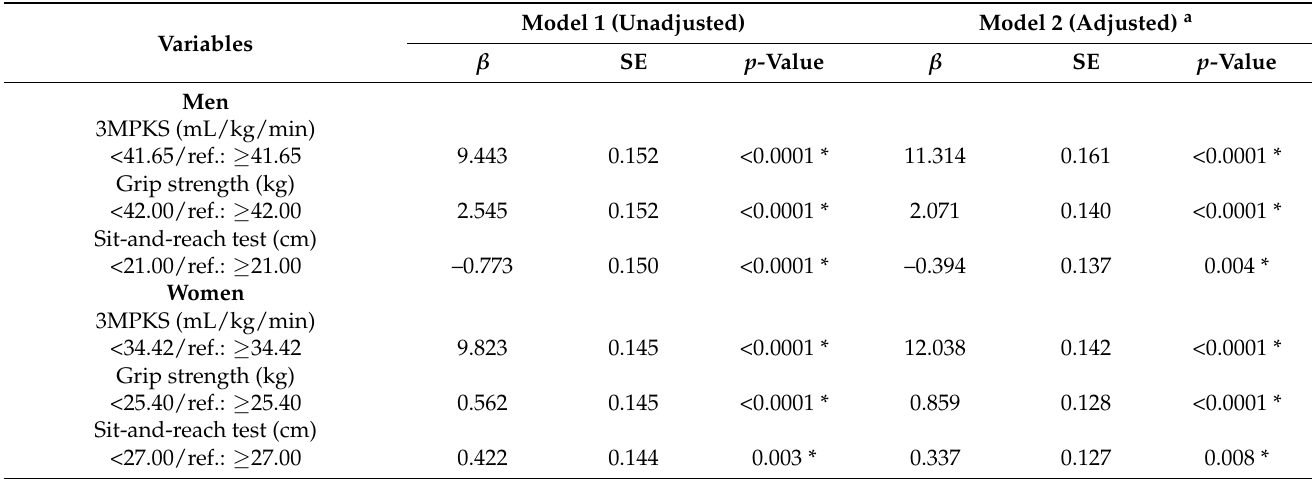
Table 4. Multiple linear regression coefficients for predicting body fat percentage using the 50th percentiles of physical fitness measurements.